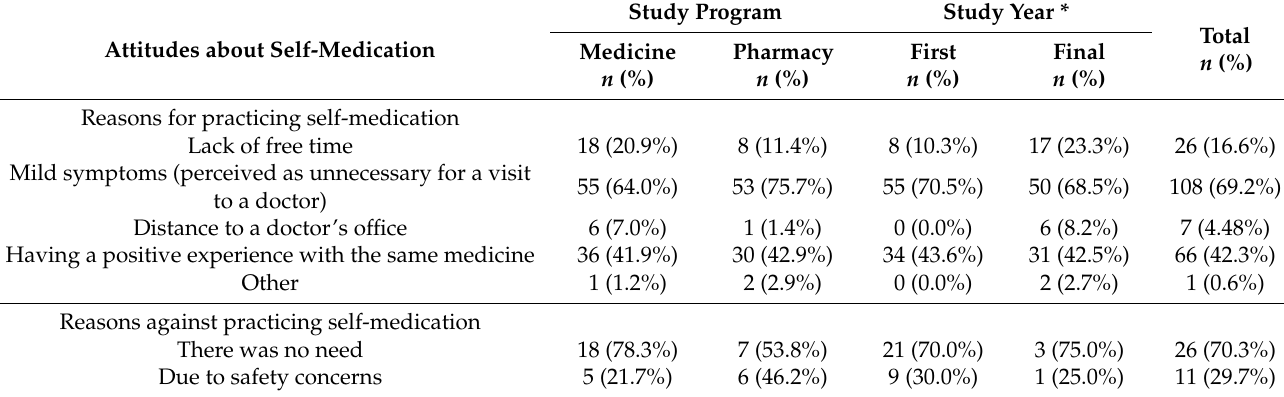
Table 2. Reasons for choosing or avoiding self-medication practice.